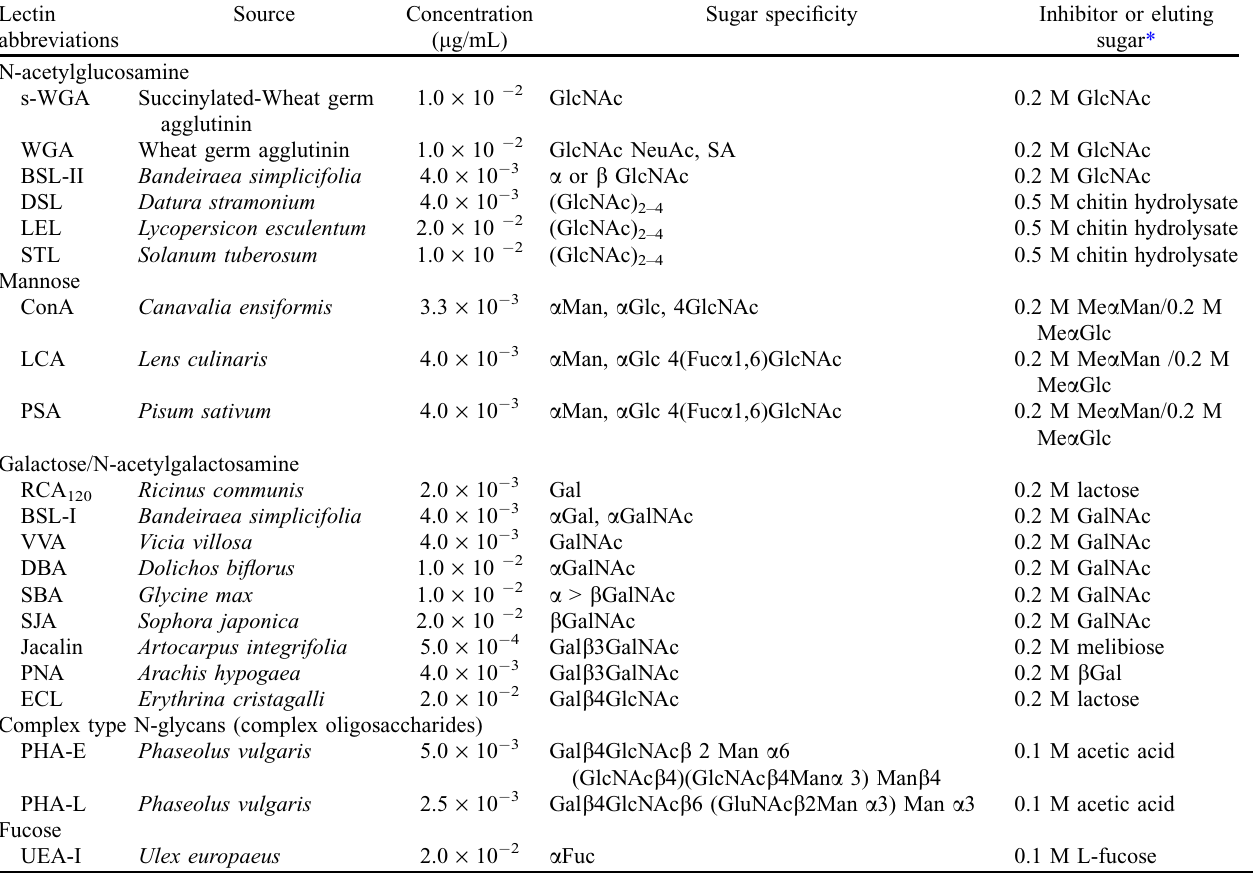
Table 1. Binding specificities of lectins used in this